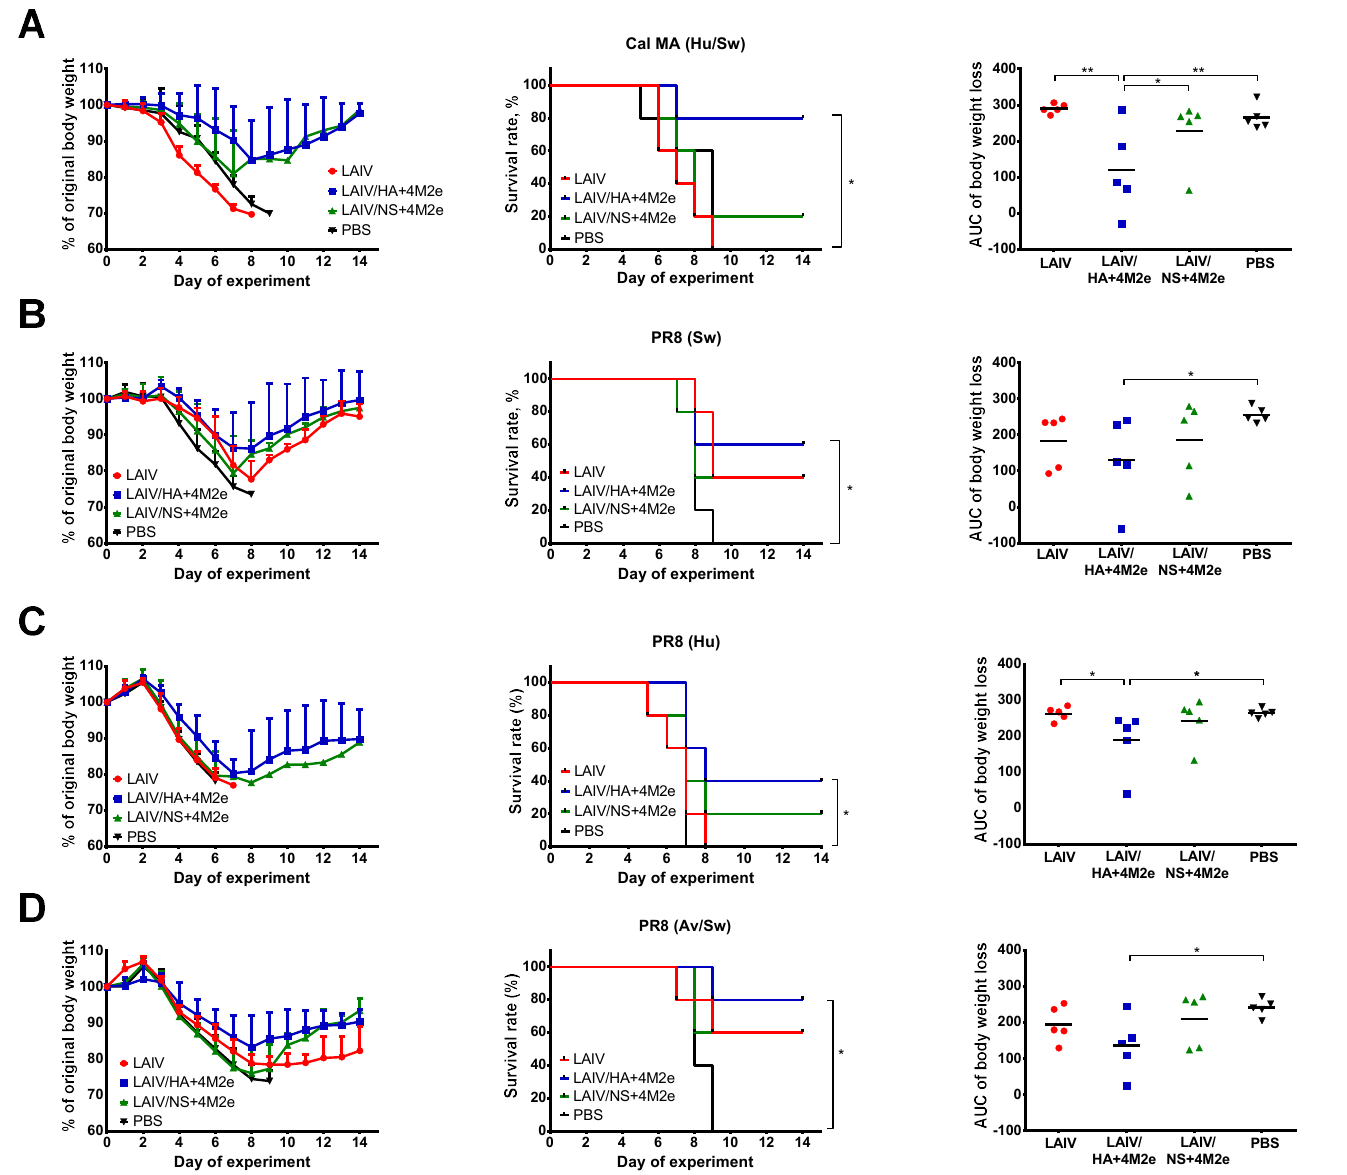
Figure 11. Protective effect of ferret immune sera in a mouse in vivo protection assay. Pooled sera collected from immunized ferrets three weeks after the second dose was mixed with one of the four viruses at a dose of 3 LD50 and inoculated intranasally to naïve C57BL/6J mice (n = 5). Survival rates and weight loss were monitored during 14 days after infection. ( A ) Cal MA H1N1 (M2e of human/swine lineage). ( B ) A/PR8 virus carrying engineered M gene of swine lineage. ( C ) A/PR8 virus carrying M gene of A/Aichi/2/1968 (H3N2) (M2 of human lineage). ( D ) A/PR8 virus with M gene of A/duck/Potsdam/1402-6/1986 (H5N2) virus (M2e of avian/swine lineage). Data were analyzed by log-rank Mantel-Cox test (middle panel) or one-way ANOVA with Tukey’s post-hoc multiple analyses test (right panel). * p < 0.05; ** p < 0.01.